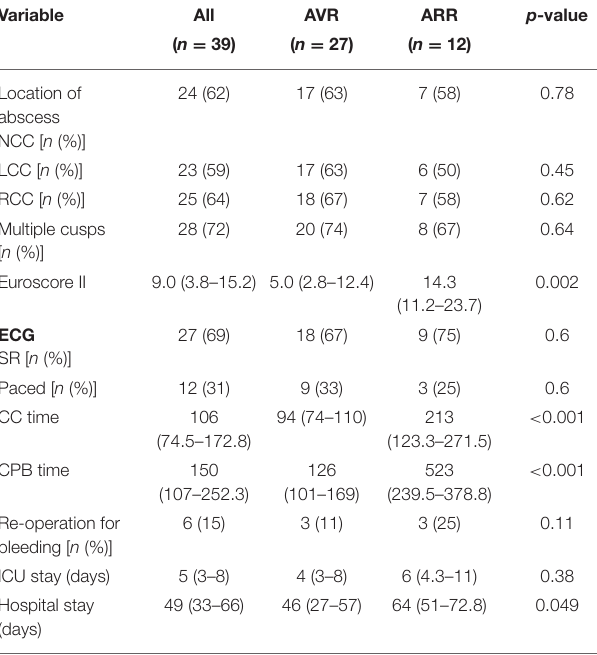
TABLE 1 | Characteristics of patients with intra-cardiac abscess who were operated on or received antibiotics alone. Variable